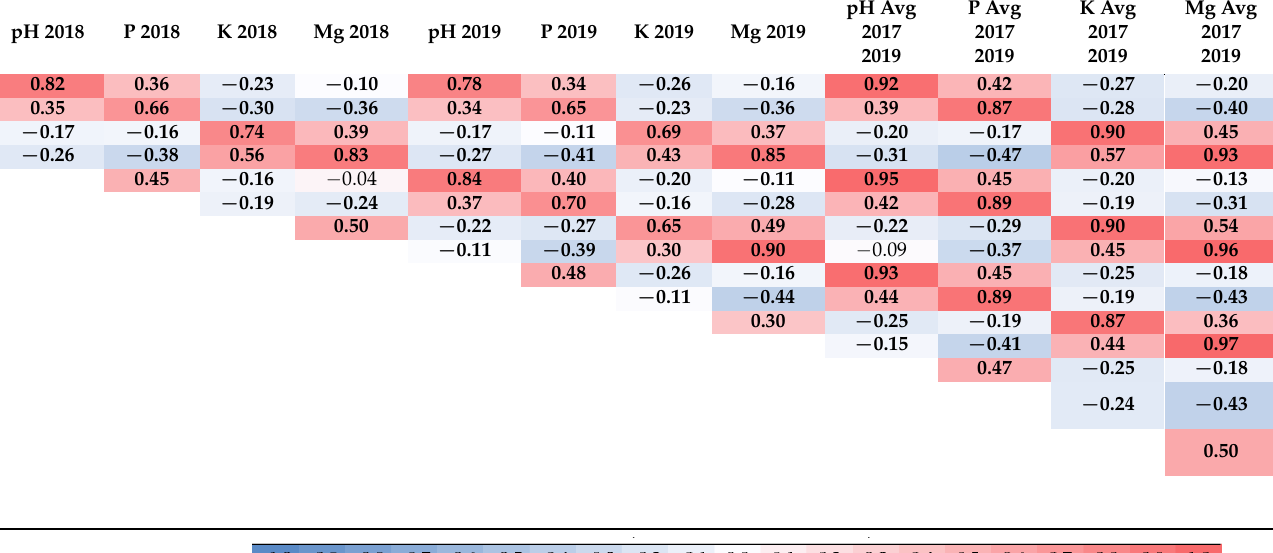
Color scale for correlation coefficients (the same for Tables 5–7):